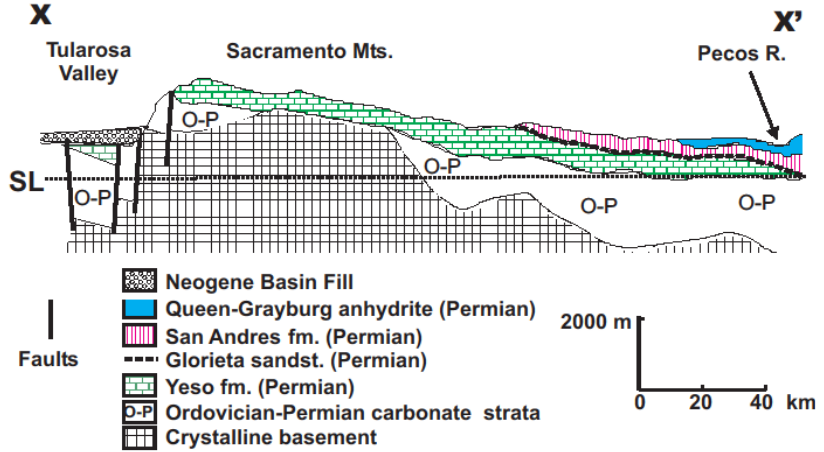
Figure 2. Cross section X-X’ (see Figure 1 for location), after Roswell Geological Society (1956). SL = sea level. The east slope of the Sacramento Mountains is a dip-slope with widespread veneer, too thin to depict here, of the Glorieta Sandstone and overlying members of the San Andres